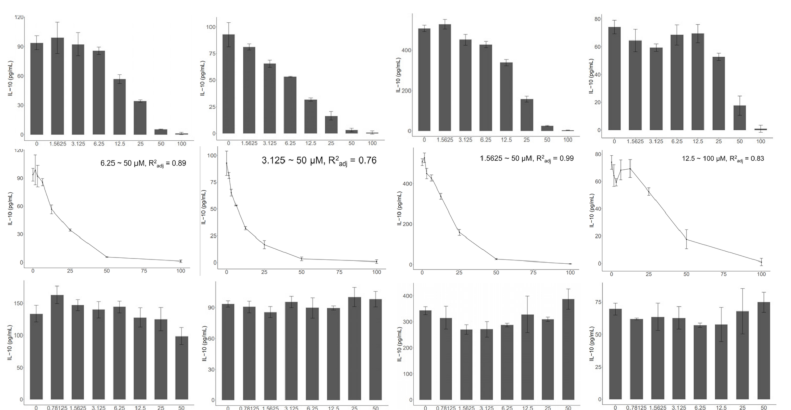
Figure 2. TLR2-dependent immune activation in the in vitro MLN model. Horizontal axis indicates the concentrations of inhibitors ( µ M) (C29: TLR2 inhibitor; TAK242: TLR4 inhibitor); vertical axis represents the levels of IL-10 in the co-culture supernatant. Adjust R square was calculated within the linear range. All tests were replicated three times.